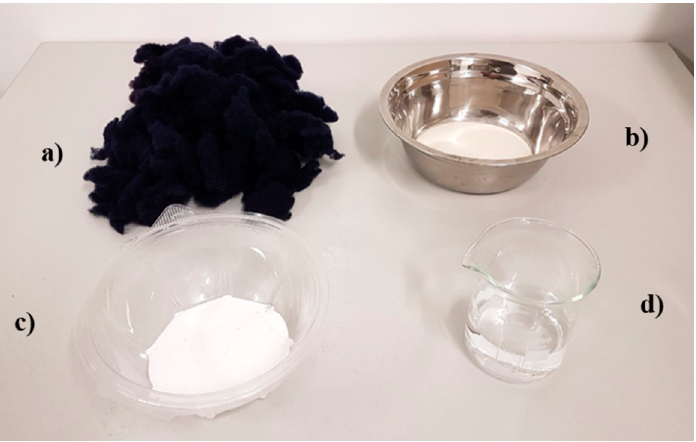
Figure 4. Materials: ( a ) Carded wool; ( b ) Gum arabic; ( c ) phase change material (PCM); ( d ) Water. Three specimens were made (Figure 5), one being the reference (without PCM) and the other two having different weight percentages of phase change material (Tables 1 and umes, when PCM increased the total weight, sample density increased too.